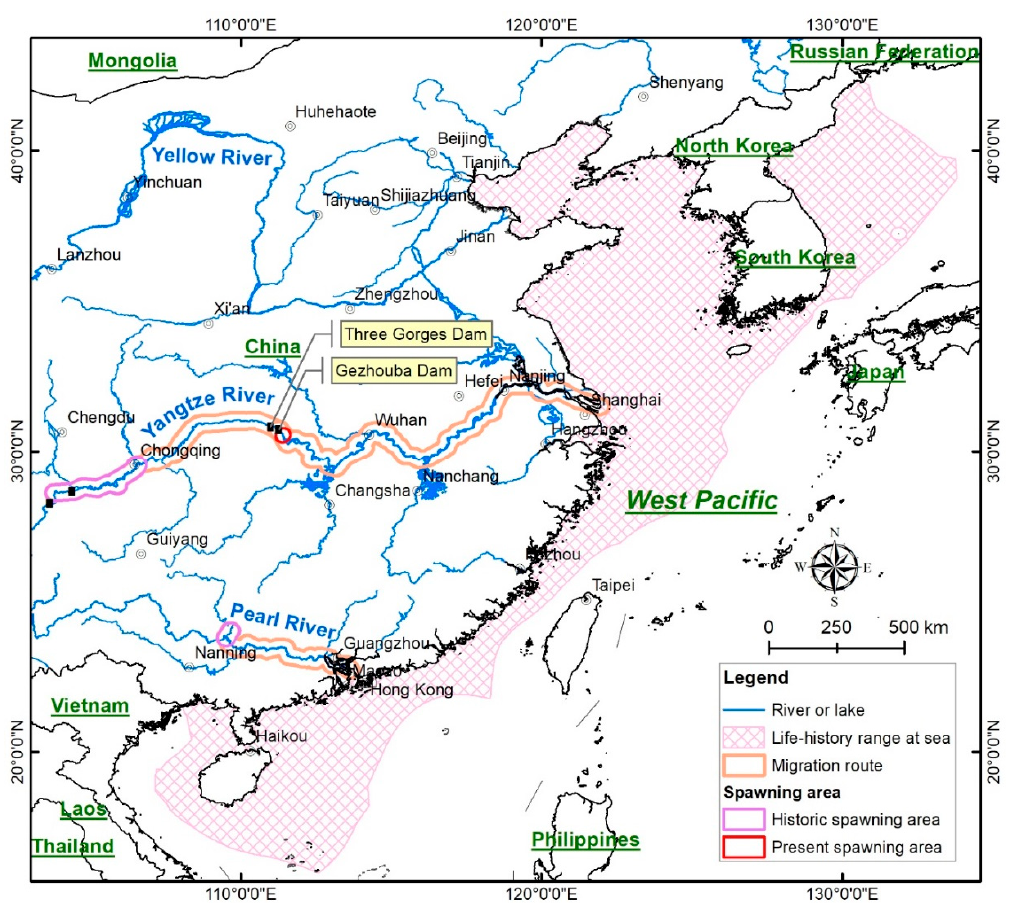
Figure 1. Life history range of the anadromous Chinese sturgeon: the species lives in the continental shelf of the west Pacific and spawns in the rivers [1,2]. Historically (i.e., before the 1980s), the spawning areas were in the upper Yangtze and Pearl rivers, however, since 1981, only one remaining spawning area has been reported below the Gezhouba Dam in the main stem of Yangtze River [6]. Geographic data were from the National Geomatics Center of China (http://ngcc.sbsm.gov.cn).